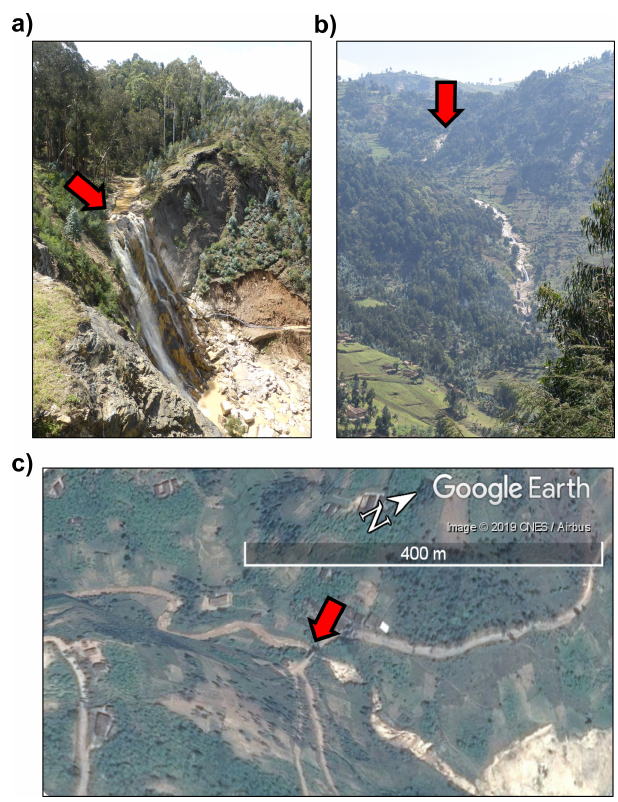
Figure 3. Field-validated knickpoints in Rwanda. The red ar- row indicates the location of the knickpoint: (a) east of Mabanze, Rwanda (2.047852 ◦ S, 29.469678 ◦ E); (b) east of Kanama, Rwanda (1.705683 ◦ S, 29.391763 ◦ E); (c) southwest of Kibilira, Rwanda (1.980443 ◦ S, 29.61586 ◦ E). Image © 2019 Google